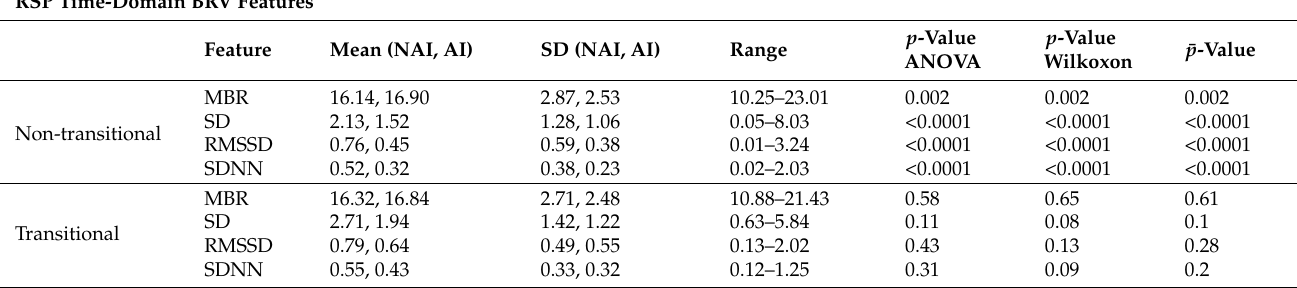
Table 4. RSP time domain BRV Features. Mean breath rate: MBR; standard deviation of breath rate (SD); root mean square of successive differences: RMSSD; standard deviation of NN intervals: SDNN; non-anxiety-induced (NAI); anxiety-induced